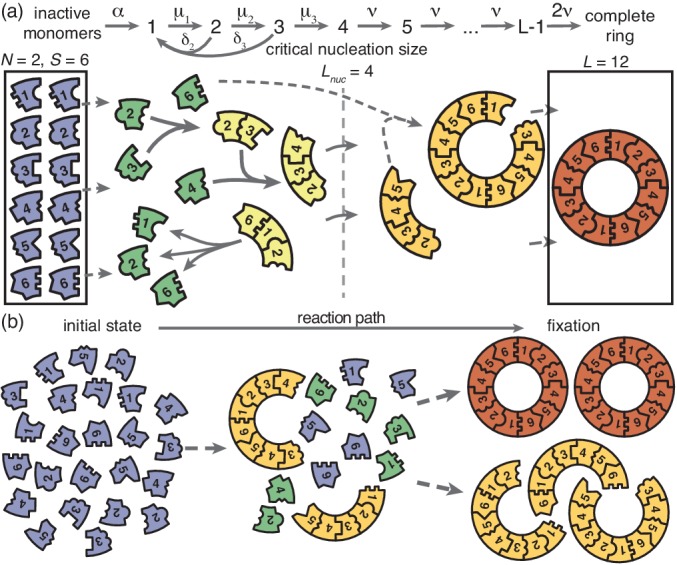
Schematic description of the model.(a) Rings of size L are assembled from S different particle species. N monomers of each species are initially in an inactive state (blue) and are activated at the same per-capita rate α. Once active (green), species with periodically consecutive index can bind to each other. Structures grow by attachment of single monomers. Below a critical nucleation size (Lnuc), structures of size l (light yellow) grow and decay into monomers at size-dependent rates μl and δl, respectively. Above the critical size, polymers (dark yellow) are stable and grow at size-independent rate ν until the ring is complete (the absorbing state; red). (b) Illustration of depletion traps. If nucleation is slow compared to growth, initiated structures are likely to be completed. Otherwise, many stable nuclei will form that cannot be completed before resources run out.